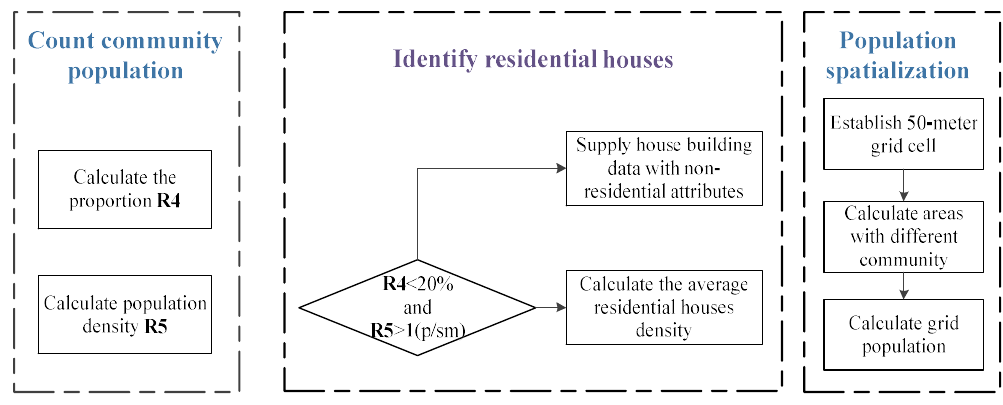
Figure 3. Workflow of the Population Spatialization Method on the District Level.